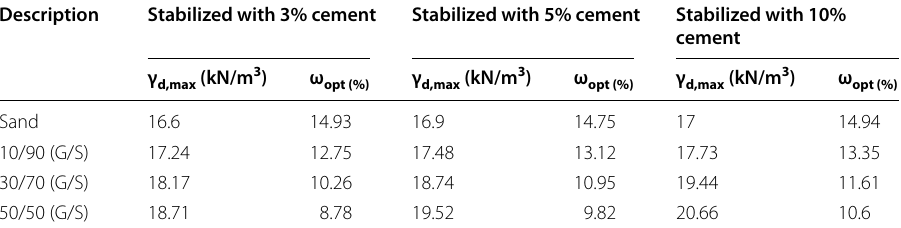
Table 2 Compaction and properties of stabilized SP and CG–SP blends